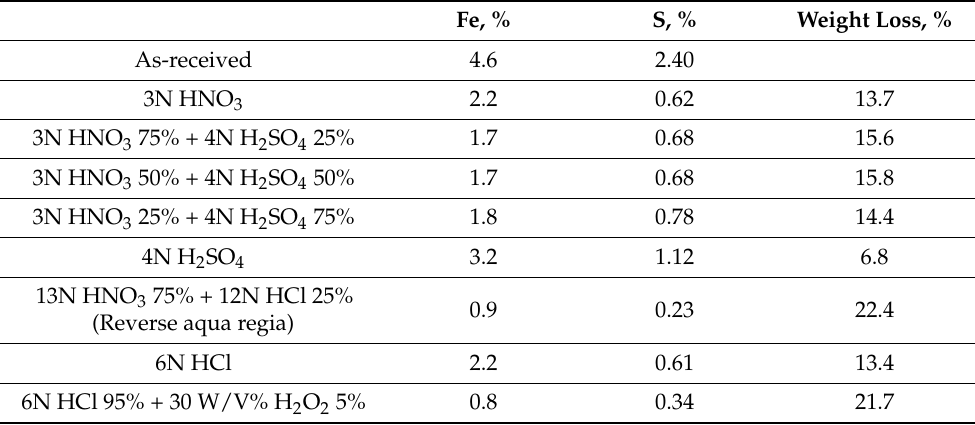
Table 4. Iron and sulfur contents in shungite samples leached using inorganic acids. Fe, % S, % Weight Loss,